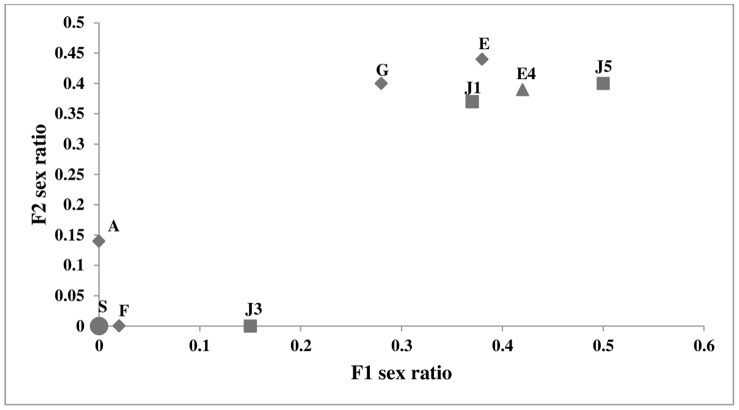

C. undecimpunctata matrilines females & F1 females sex ratio (proportion of male offspring) with standard error.Matrilines are labeled as in Figure 1. The letter “S” and the circle symbol represent all lines that have zero sex ratio in both F1 and F2 from the three collections (B, E1, E2, E3, J2 & J4).